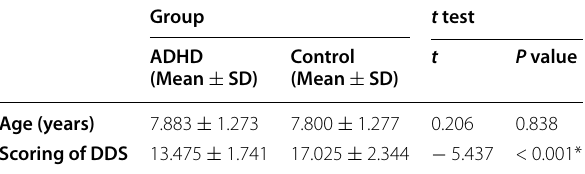
Table 1 Comparison of DDS score means between genders Scoring of DDS Sex